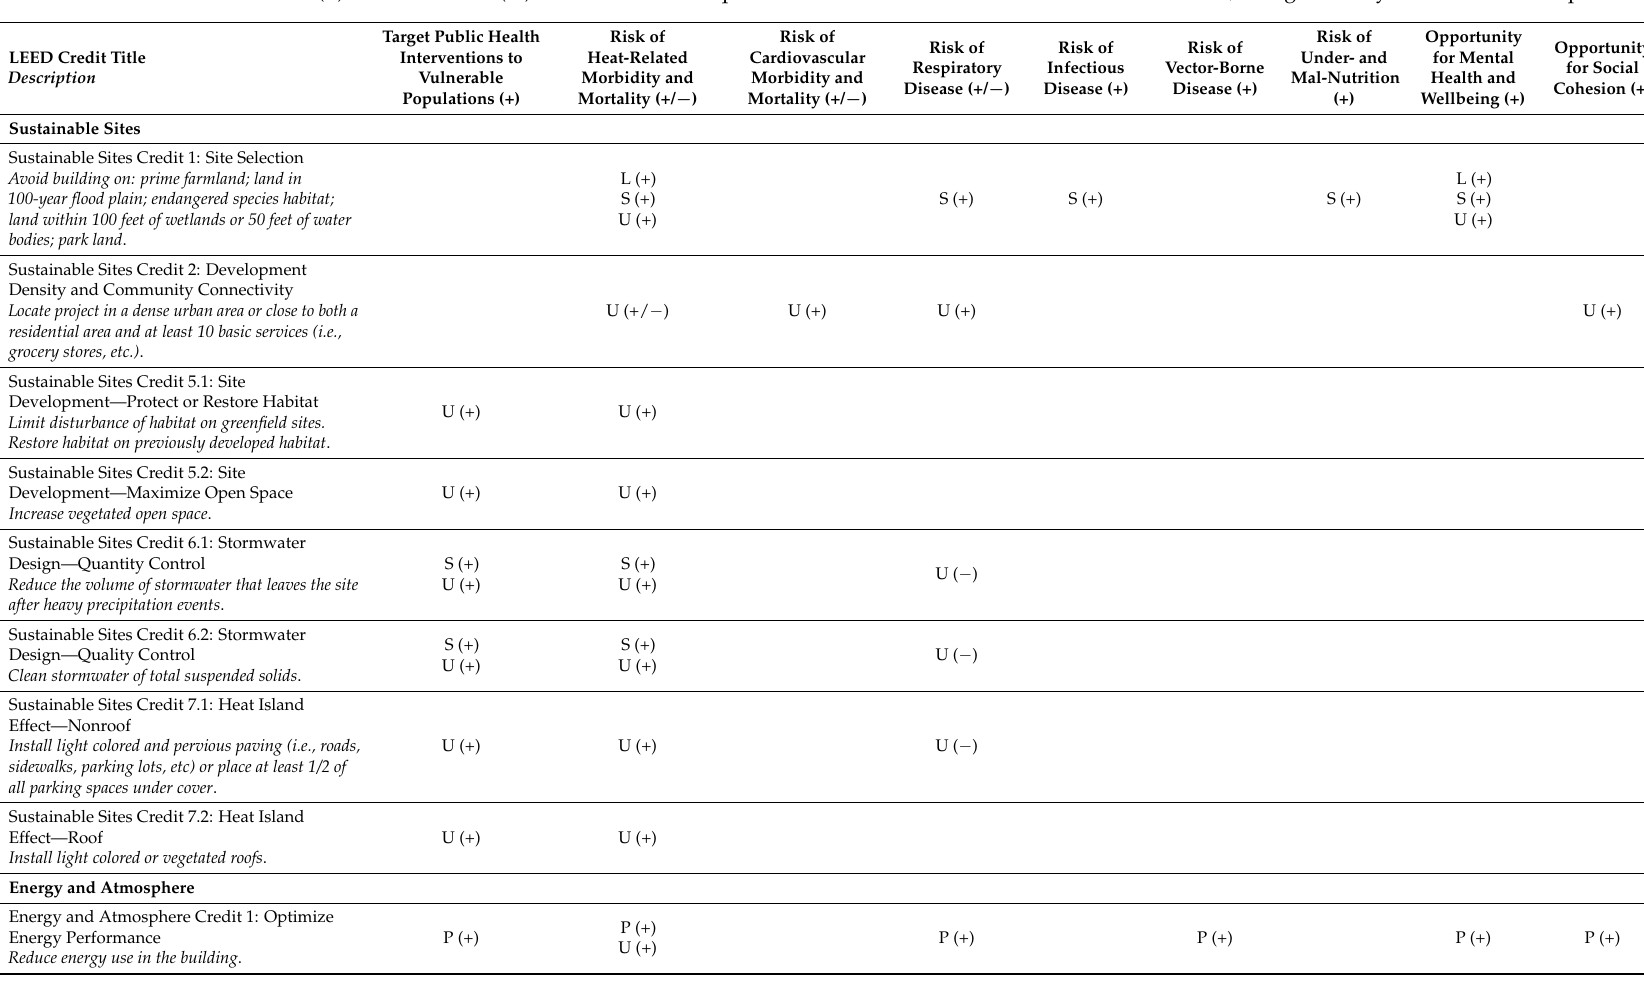
Table 2. Potential Co-Benefits (+) and Co-Harms ( − ) of LEED Credit Requirements on Heat-Related Public Health Outcomes, Categorized by Environmental Exposure. LEED Credit Title